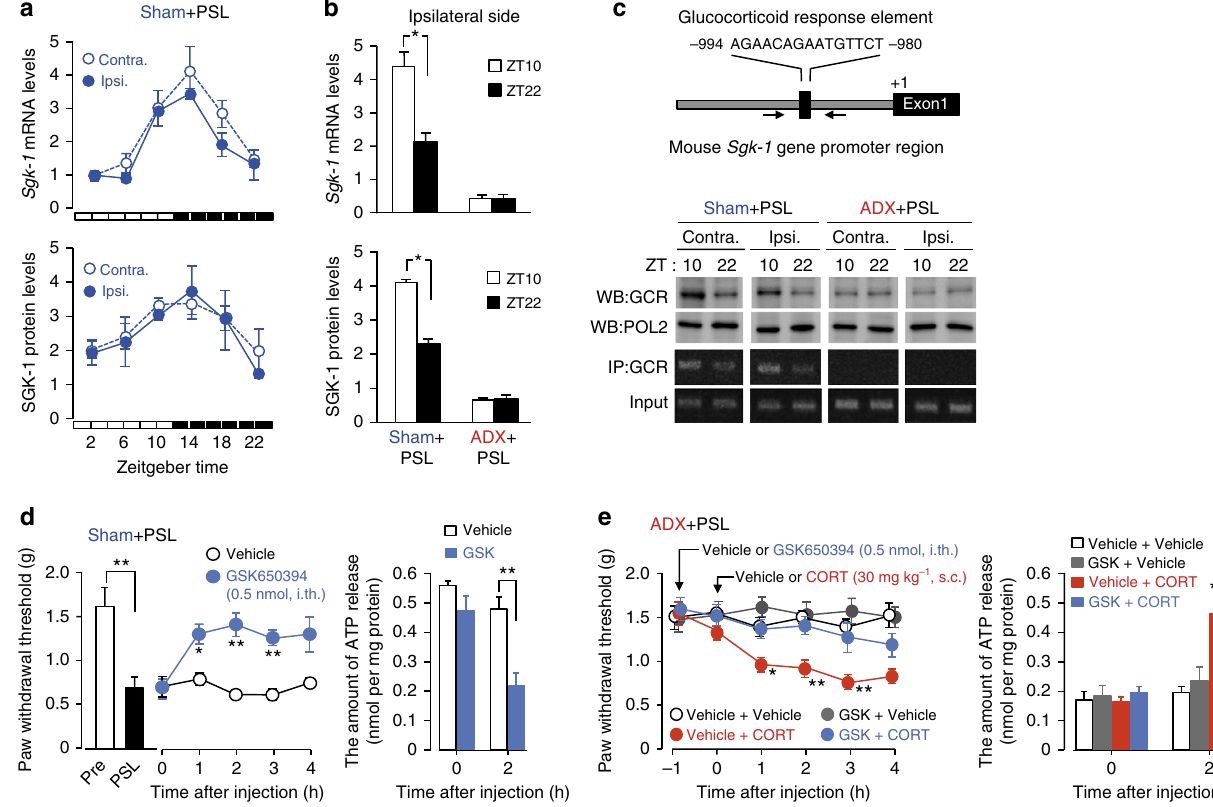
Figure 4 | SGK-1 mediates the glucocorticoid-regulated diurnal oscillations in the threshold of mechanical allodynia in PSL mice. ( a , b ) Diurnal oscillations in the spinal expression of SGK-1 is dependent on glucocorticoid (means ± s.e.m.; n ¼ 5). Significant time-dependent variations were observed in the levels of Sgk-1 mRNA and its protein in the contralateral (Contra.) ( F 5,24 ¼ 33.233, P o 0.001 for mRNA; F 5,24 ¼ 4.808, P ¼ 0.006 for protein; ANOVA) and the ipsilateral (Ipsi.) sides ( F 5,24 ¼ 14.996, P o 0.001 for mRNA; F 5,24 ¼ 4.591, P ¼ 0.007 for protein; ANOVA). * P o 0.05 significant difference between two time points ( F 3,16 ¼ 105.464, P o 0.001 for mRNA; F 3,16 ¼ 670.562, P o 0.001 for protein; ANOVA with Tukey–Kramer’s PHT). ( c ) The temporal binding profiles of the GCR to the Sgk-1 promoter in the spinal cords of sham þ PSL and ADX þ PSL male mice. GCR and RNA polymerase 2 (POL2) in the nuclear fraction of spinal cords were detected by western blotting (WB). Immunoprecipitates (IP) with anti-GCR antibodies were subjected to a PCR analysis. Solid line arrows in the upper panel represent PCR amplification areas. Data are representative of three independent experiments. Full- size images of WB are presented in Supplementary Fig. 13. ( d ) The intrathecal (i.th.) injection of the SGK-1 inhibitor GSK650394 (0.5nmol per mouse) alleviates pain hypersensitivity of the ipsilateral hindpaw in male sham þ PSL mice and suppresses of spinal ATP release (means ± s.e.m.; n ¼ 5), ** P o 0.01, * P o 0.05 significantly different from vehicle-treated groups at the corresponding time points ( F 9,40 ¼ 8.876, P o 0.001 for pain threshold, F 3,16 ¼ 12.454, P o 0.001 for ATP release; ANOVA with Tukey–Kramer’s PHT). ( e ) The SGK-1 inhibitor GSK650394 (0.5pmol per mouse, i.th.) prevents CORT (30mgkg (cid:2) 1 , s.c.)-induced pain hypersensitivity of the ipsilateral hindpaw in male ADX þ PSL mice and suppresses spinal ATP release (means ± s.e.m.;